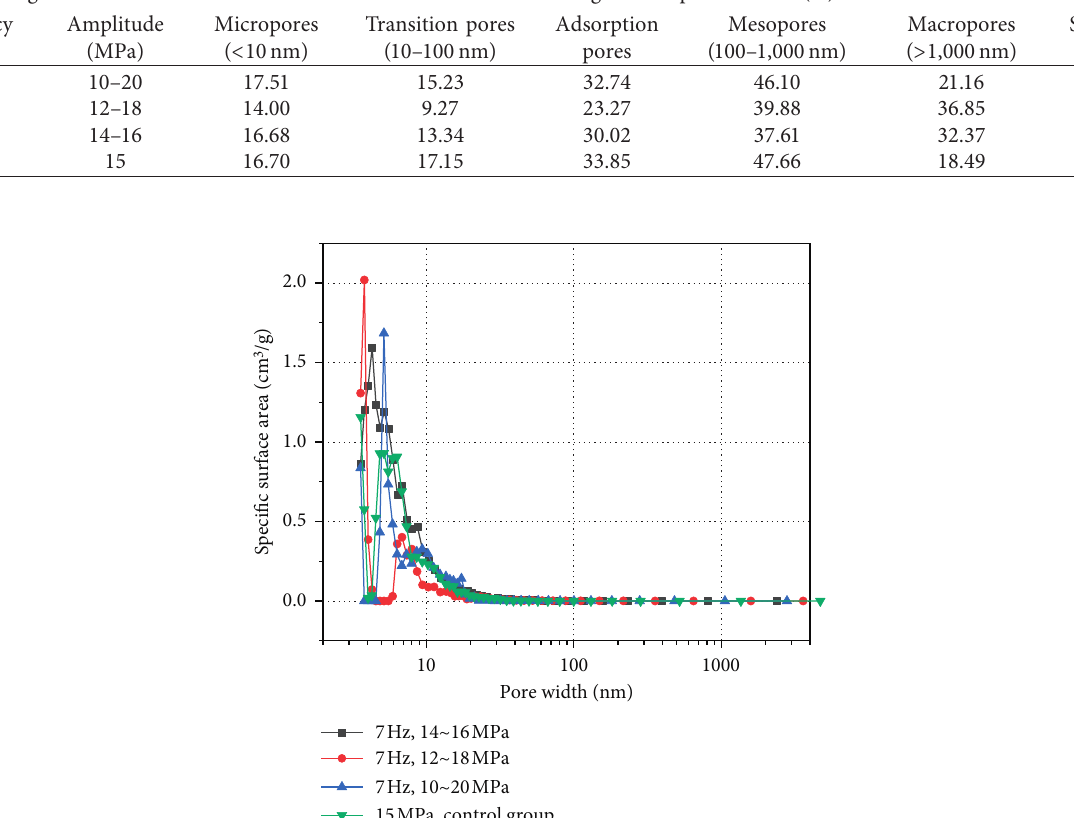
Figure 10: Distribution of porosities contributed by adsorption and seepage pores at different loading amplitudes. Table 5: Percentages of the pore volume at different loading amplitudes. Loading condition